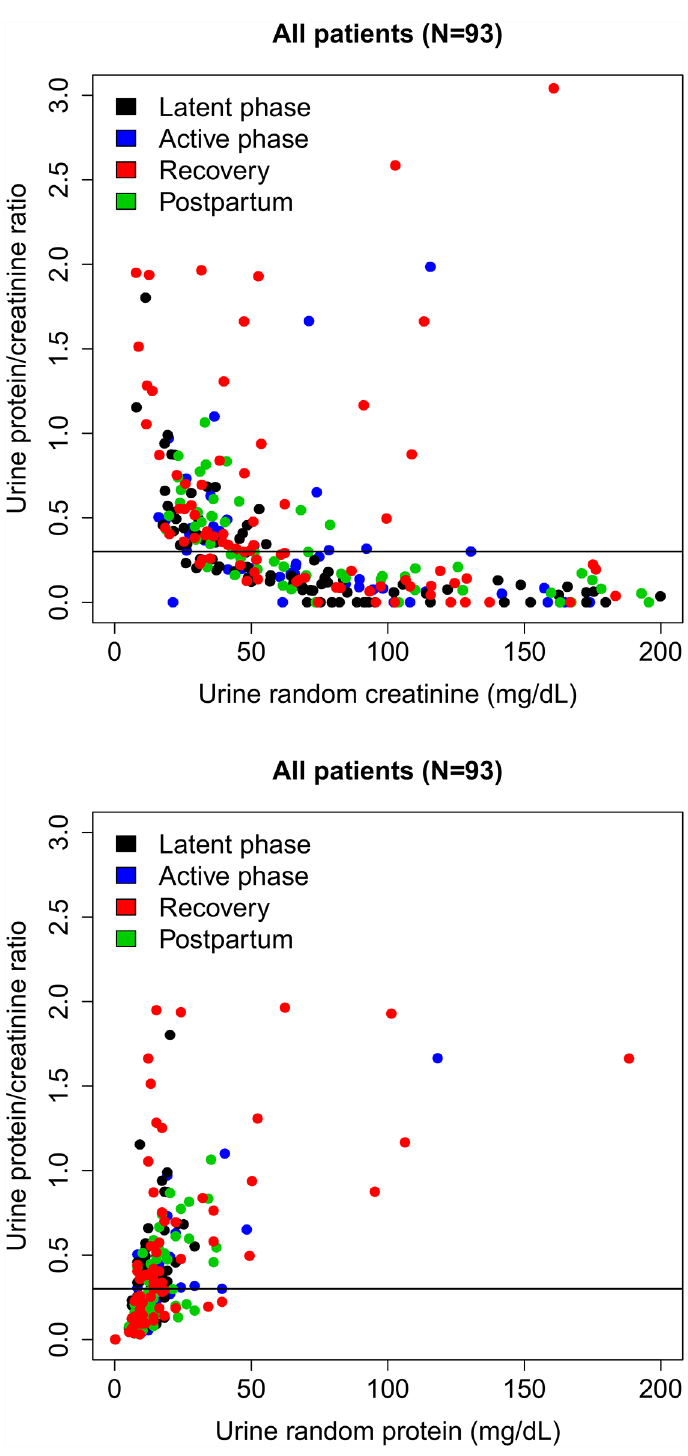
Fig 1. Urine protein/creatinine ratio (uPCR) by urine creatinine and protein concentrations. uPCR measurements plotted by urine random creatinine (top) and protein (bottom) concentrations and colored by phase of labor and delivery admission. Horizontal line on each graph represents uPCR =